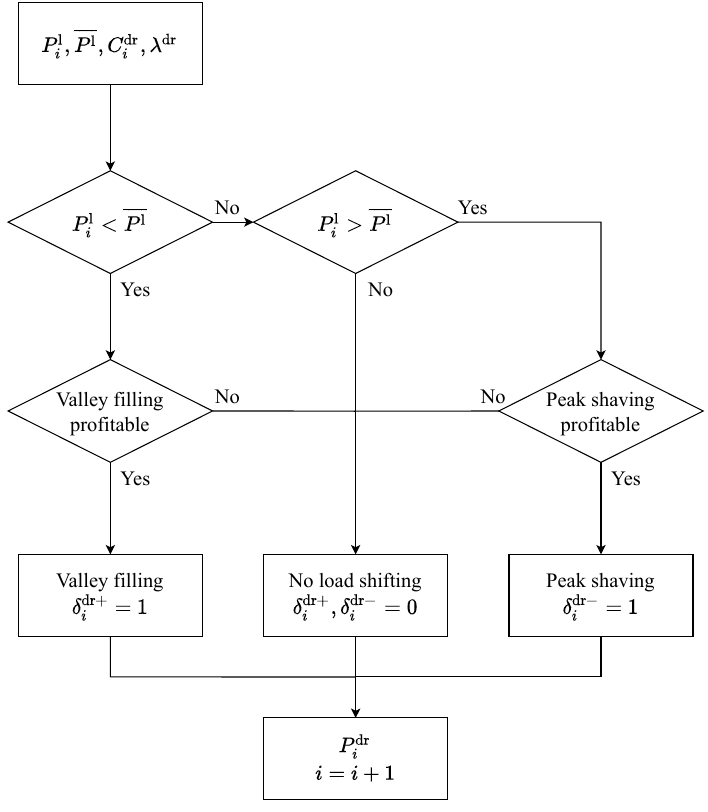
Figure 5. Demand response